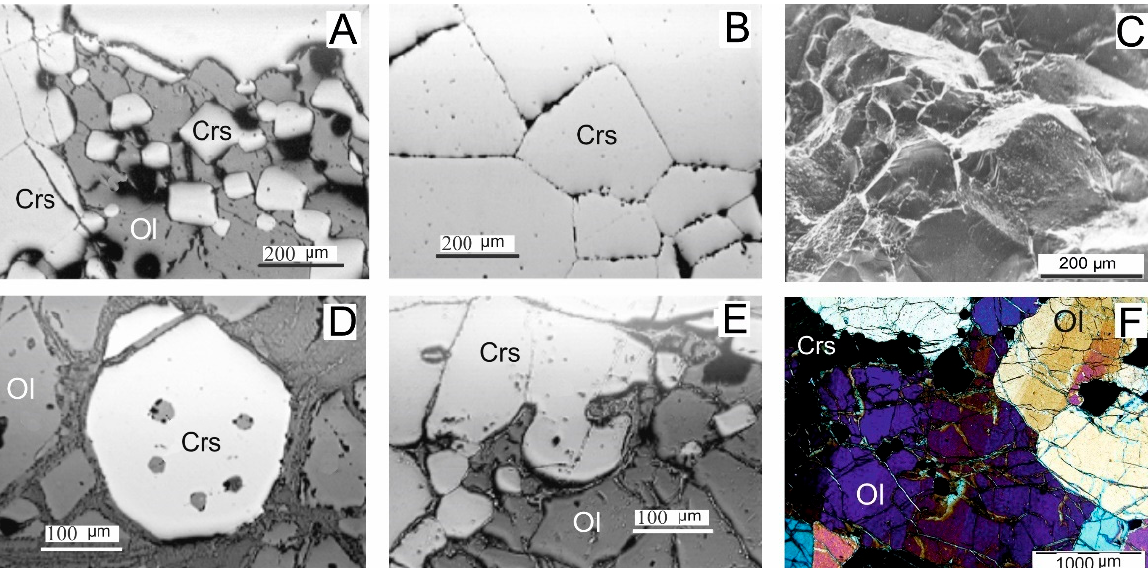
Figure 8. The morphological types of Cr-spinels and deformation of olivine from the Sopcheozero deposit: ( A ) Fine-grained Cr-spinel (Crs) included in the olivine (Ol) marginal part (sample 1585/132.6); ( B , C ) Homogeneous Cr-spinel grains forming the densest package without inclusions of silicates (sample 1585/132.6); ( D ) The inclusions of olivine in Cr-spinel (sample 1598/33.,6); ( E ) Idiomorphic combination of olivine and Cr-spinel (sample 1651/244.9); ( F ) Deformation of the olivine with polysynthetic twinning (sample 1651/201.4); ( A , B , D , E ) Back-scattered electron (BSE) images; ( C ) Secondary electron (SE) image; ( F ) Cross polarized light (CPL) image.